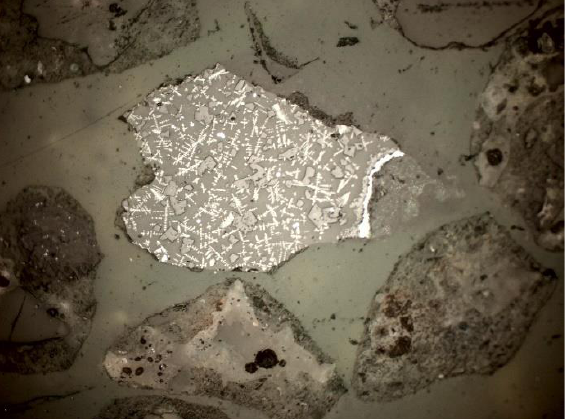
Figure 25. Metallic substance. Unburned fragment of anthropogenic origin. SP3 sample, thin section, 2P, 100×, reflected light.